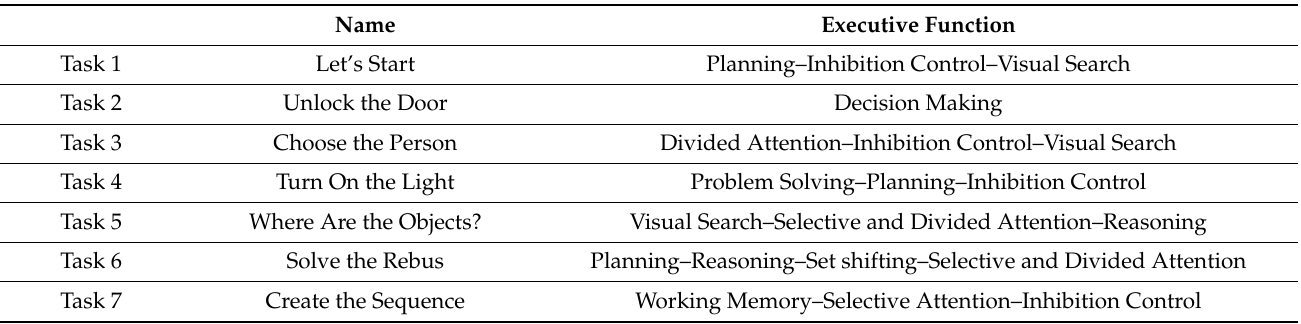
Table 2. EXIT 360 ◦ subtasks and related executive